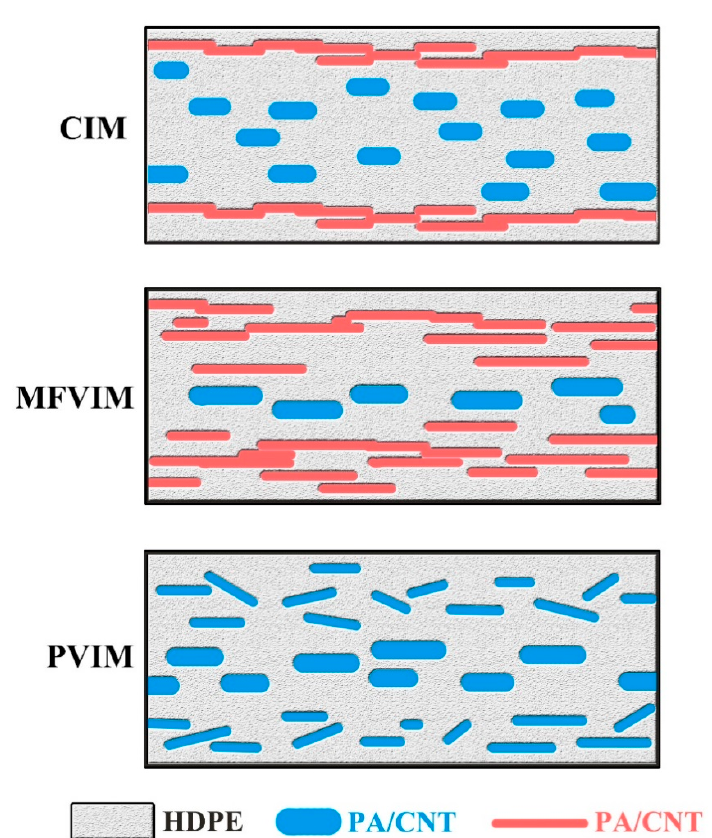
Figure 11. Relationship between conductivity and phase morphology. The blue lines indicate the insulated PA / CNT, whereas the red lines represent the PA / CNT that forms the conductive path.